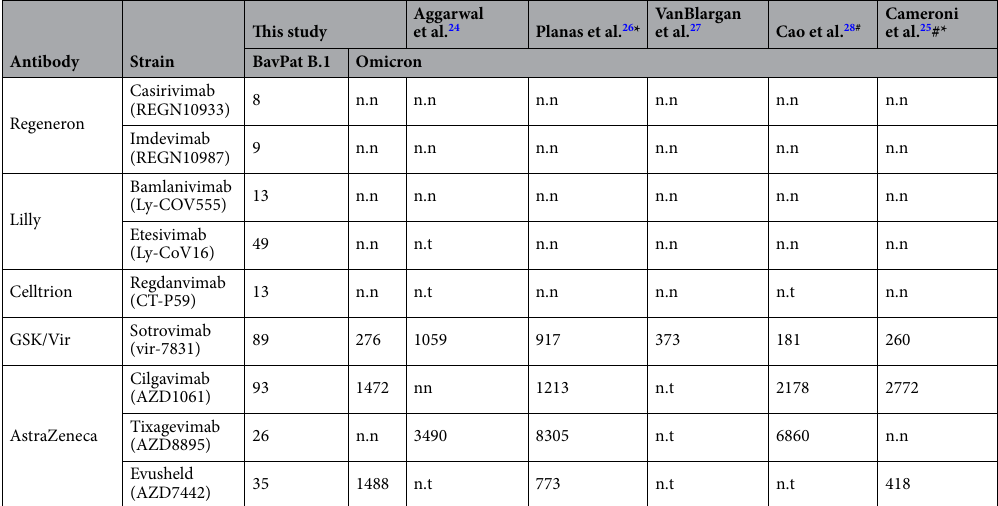
Table 1. Interpolated EC 50 values of therapeutic antibodies against SARS-CoV-2 BavPat1 and Omicron strains. EC 50 values are expressed in ng/mL. For Sotrovimab, Cilgavimab and Tixagevimab the EC 50 is the mean of two independent experiment (n = 2), each including three replicates. (n.n: non-neutralising at highest concentration tested; n.t.: not tested, *antibodies were produced by the authors and are not the actual therapeutic products; # tested using a pseudovirus-based